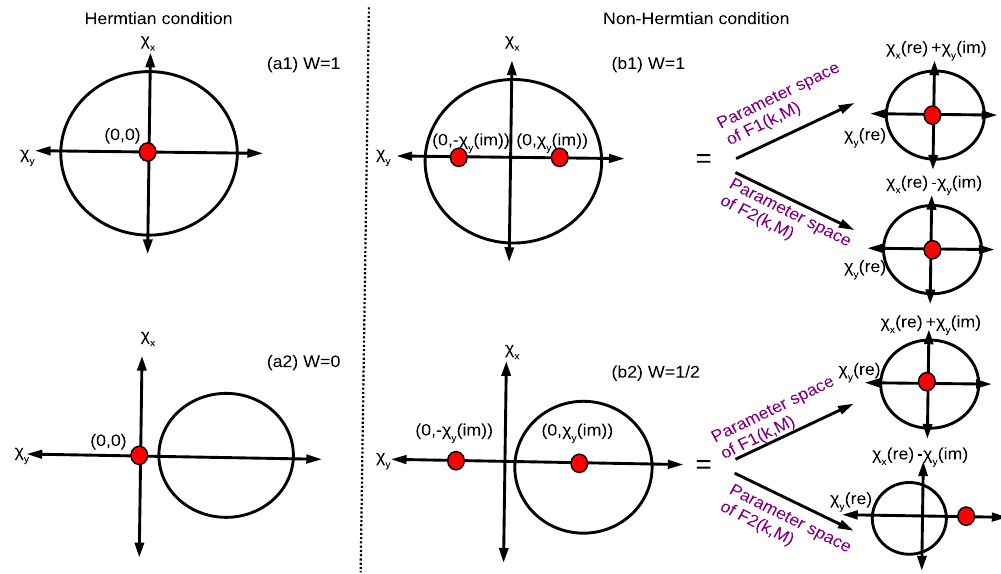
Figure 13. (Color online) Winding vector behavior of Hermitian and non-Hermitian systems. A extended winding vector can be constructed by using Eq. (6). A pseudo-spin parameter space corresponding to two exceptional points can be equivalently written as the sum of parameter spaces with modified winding